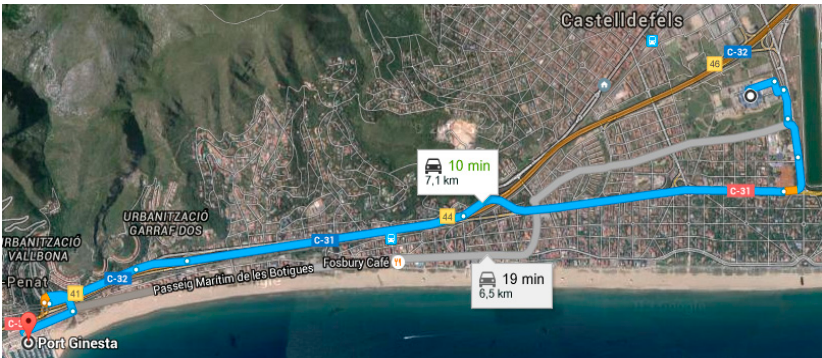
Figure 7. Route of the experiment.